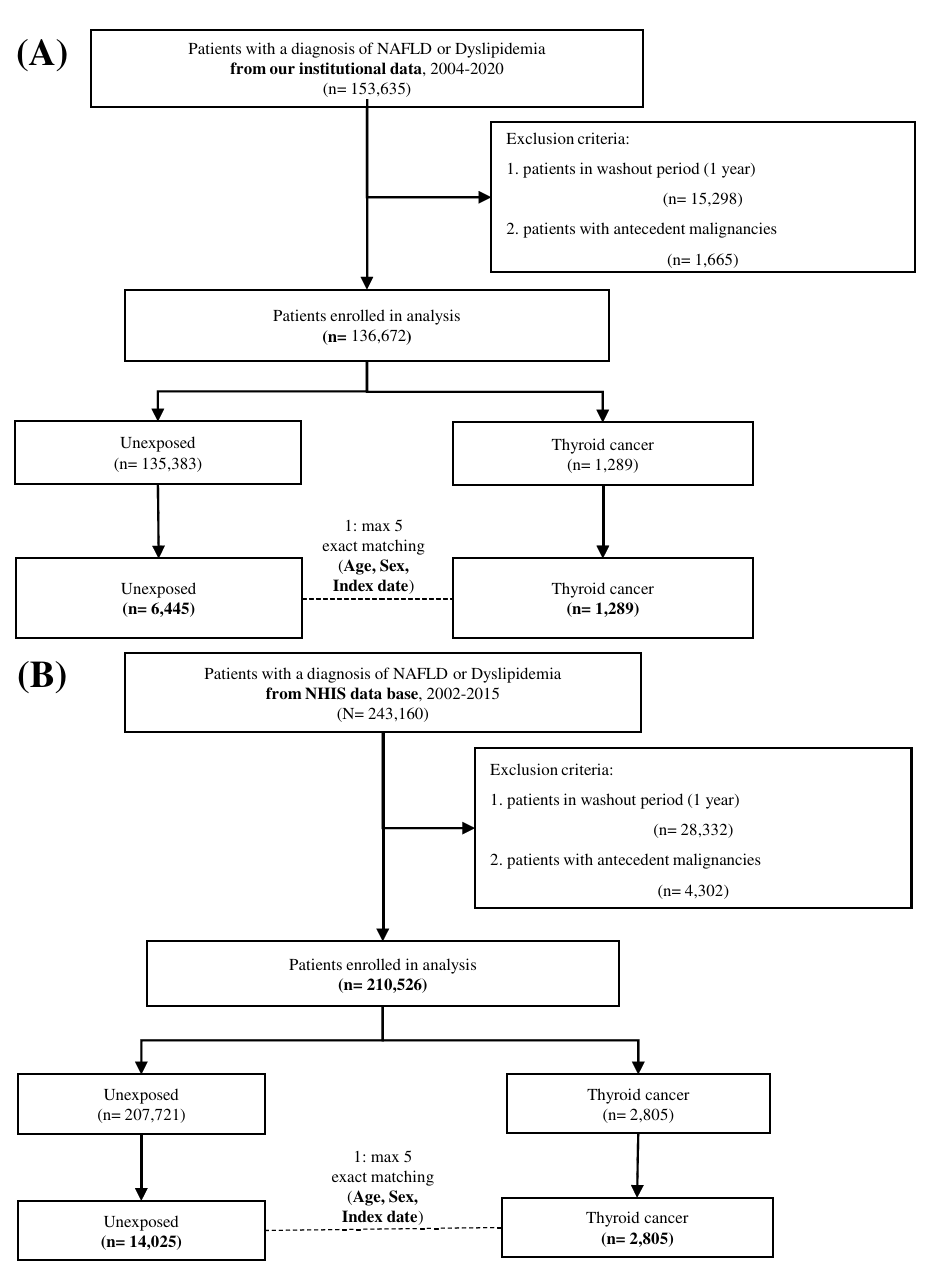
Figure 1. Schematic flow of study design using our institutional cohort ( A ) and Korean national cohort ( B ). Abbreviations: NAFLD, non-alcoholic fatty liver disease; NHIS, national health insurance